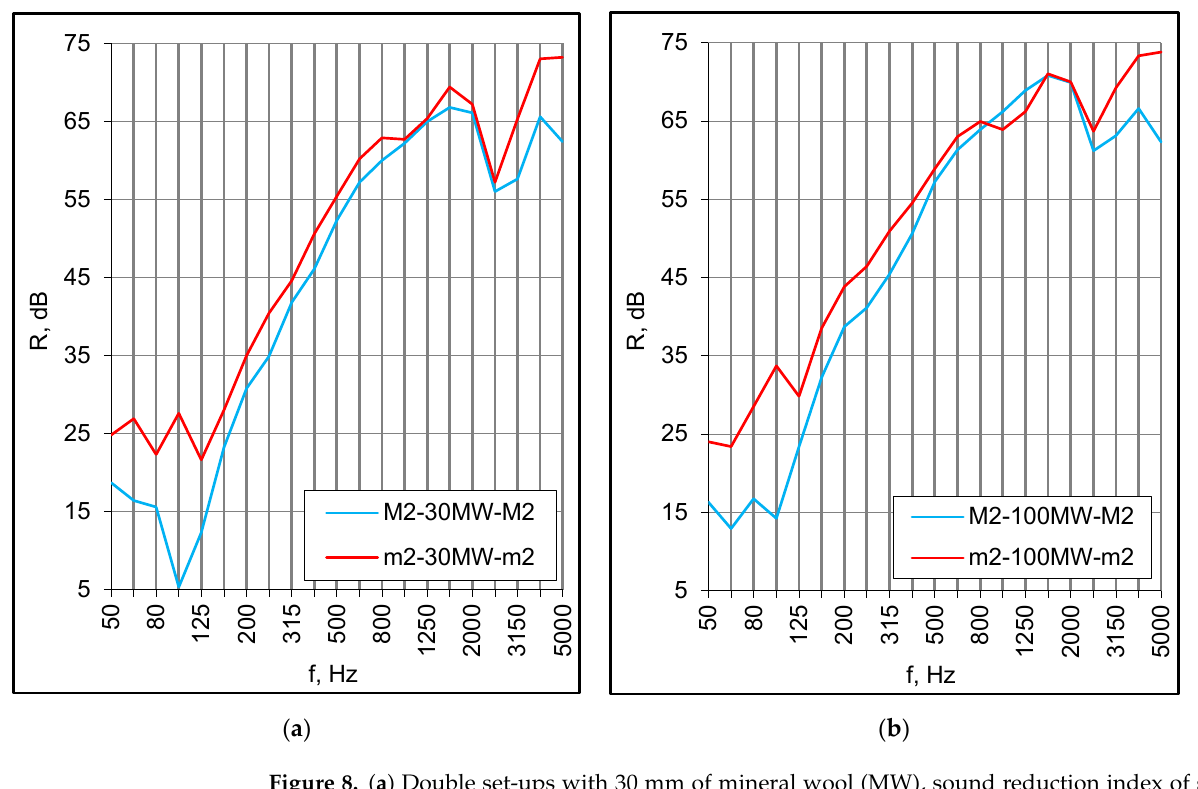
Figure 8. ( a ) Double set-ups with 30 mm of mineral wool (MW), sound reduction index of small elements and full-scale models; ( b ) Double set-ups with 100 mm of mineral wool (MW), sound reduction index of small elements and full-scale models.